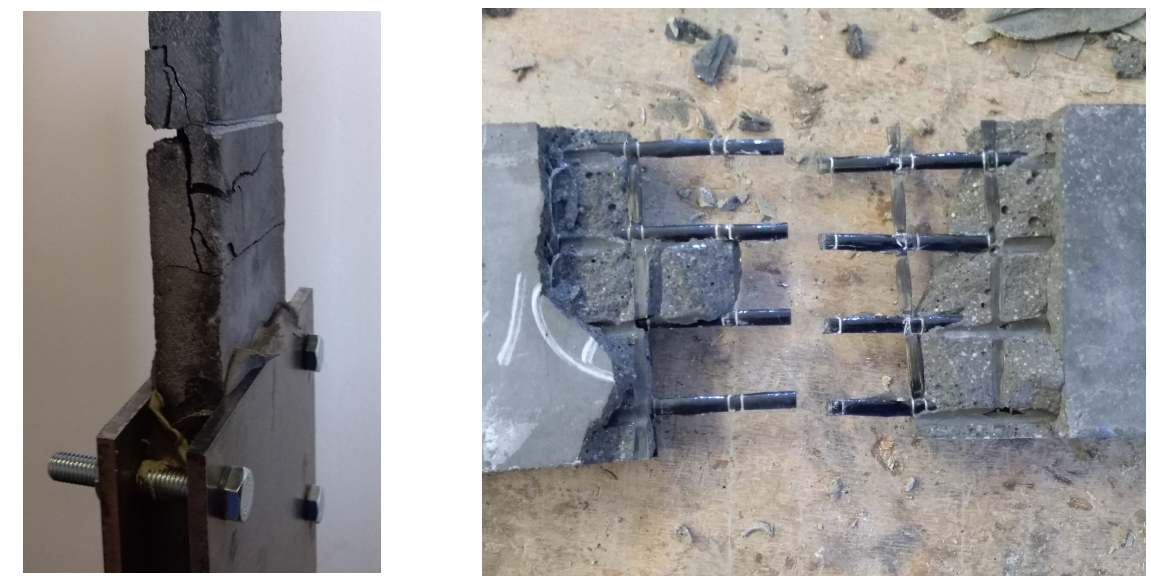
Figure 4. Typical detailed pictures of damaged specimens with shear collapse during testing procedure and just after the collapse of specimens and its uninstalling from the testing